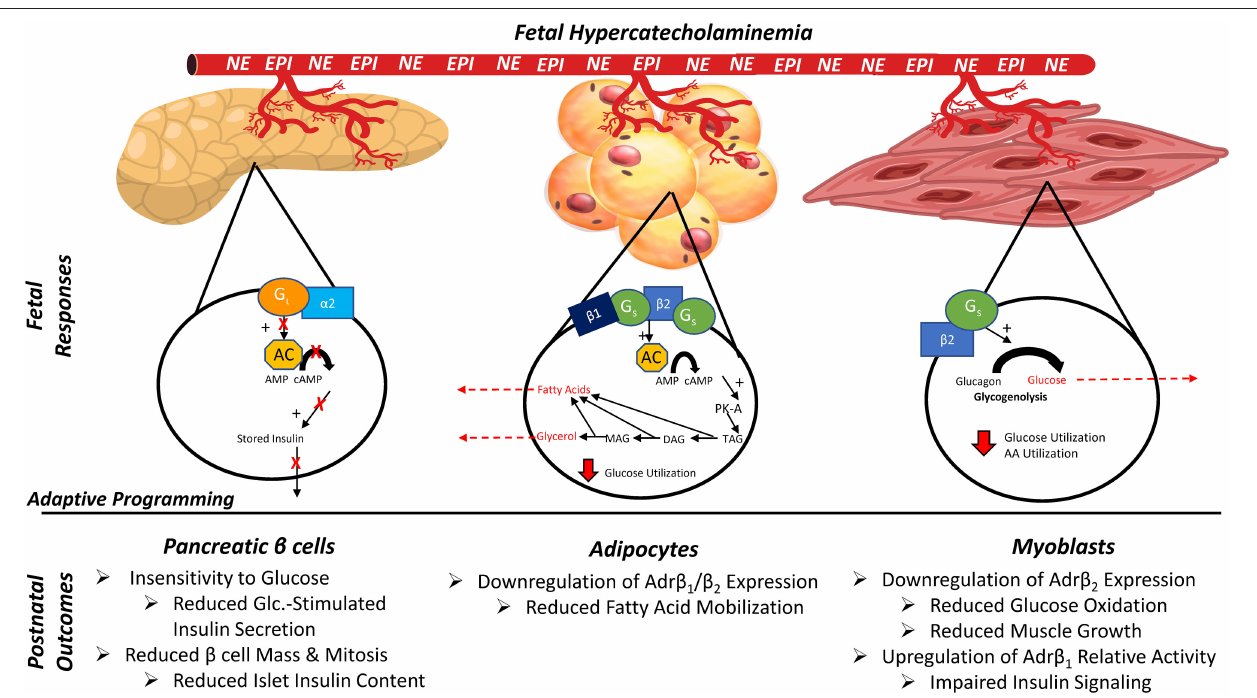
FIGURE 4 | Tissue-specific outcomes of adrenergic programming in the IUGR fetus/offspring due to chronic exposure to elevated circulating catecholamine concentrations in utero . EPI, Epinephrine; NE, norepinephrine; G i , inhibitory G-protein α subunit; G s , stimulatory G-protein α subunit; α 2, β 1, β 2, adrenergic receptors; AC, adenylyl cyclase; cAMP, cyclic AMP; PKA, protein kinase A; TAG/DAG/MAG, tri/di/monoacylglycerol; AA, amino